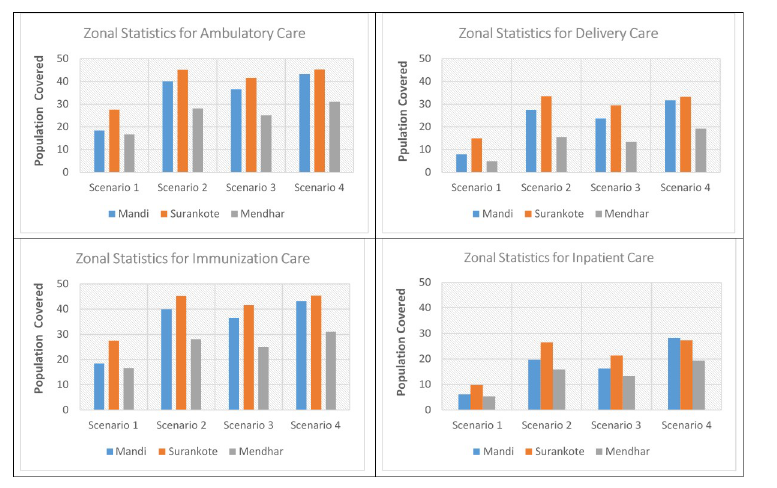
Fig 10. Zonal statistics for population